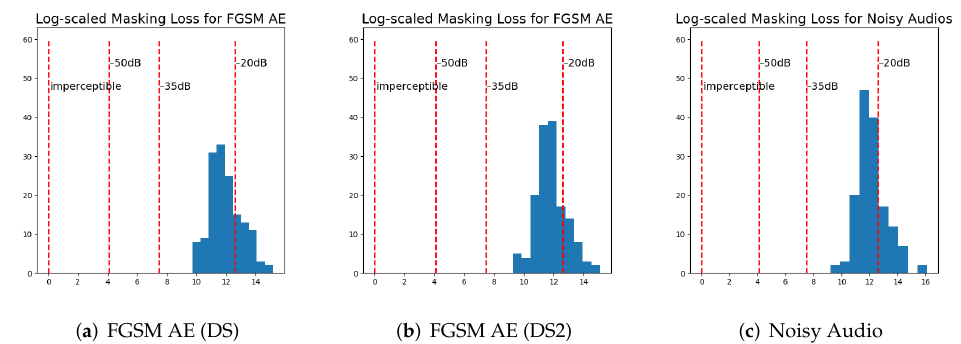
Figure 2. Histograms comparing the masking loss of fast gradient sign method (FGSM) AEs and noisy audio for DeepSpeech (DS) and DeepSpeech2 (DS2) with the − 20 dB distortion, − 35 dB distortion, and − 50 dB distortion sets published by [9] (labeled as − 20 dB, − 35 dB, and − 50 dB) and the first set of imperceptible adversarial examples published by [36] (labeled as imperceptible). Coordinates of the horizontal axis are calculated as ln ( loss + 1 ) , where loss is the masking loss proposed by [36]. We can see that the masking loss of FGSM AEs is similar to the masking loss of noisy